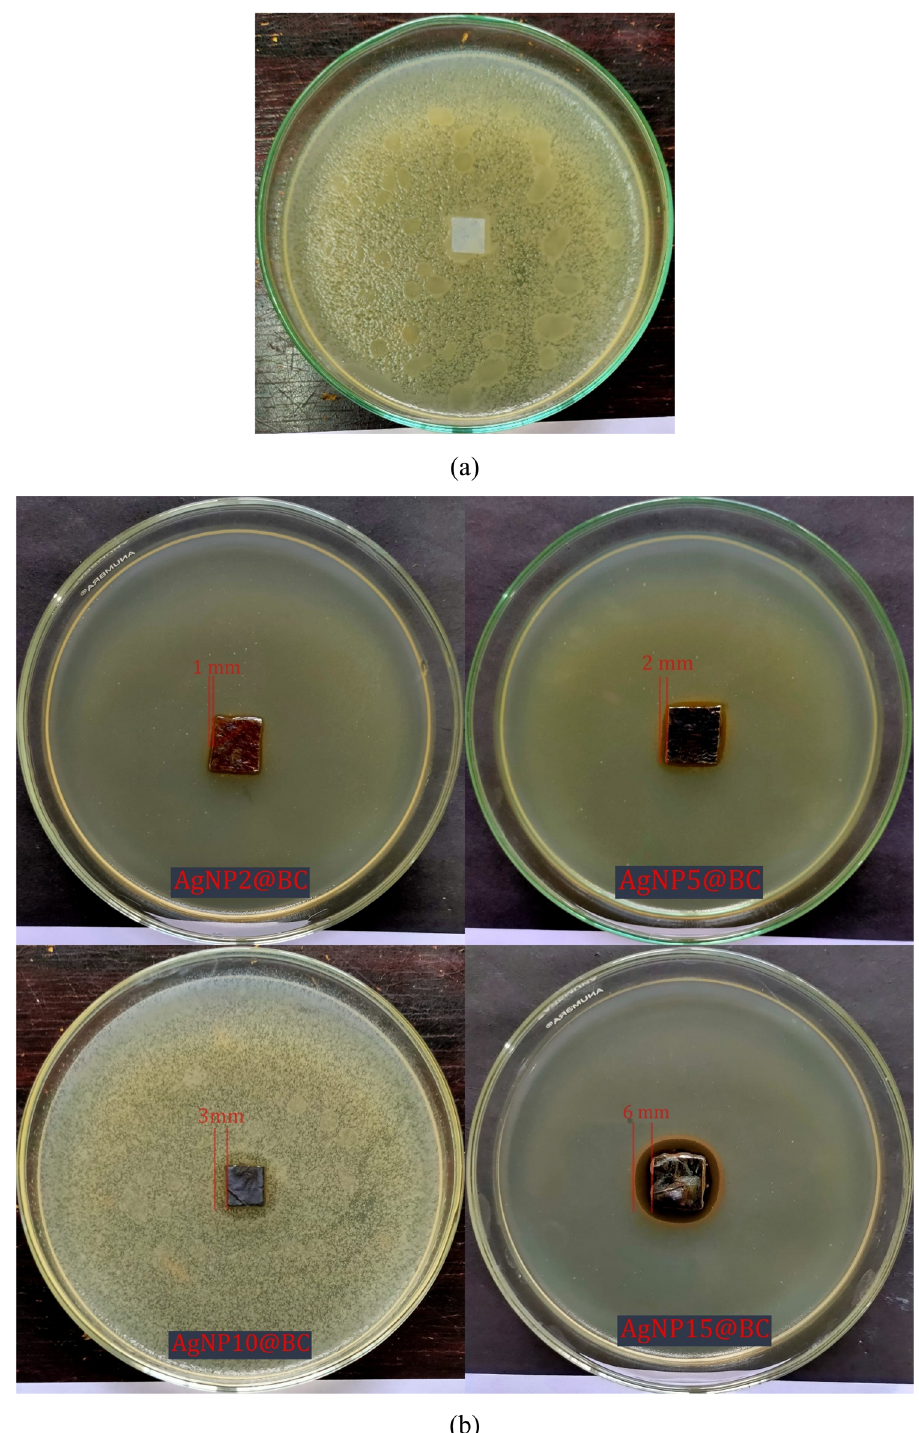
Figure 9: Antibacterial activity against E. coli of: ( a ) pristine BC and ( b ) AgNPs templated